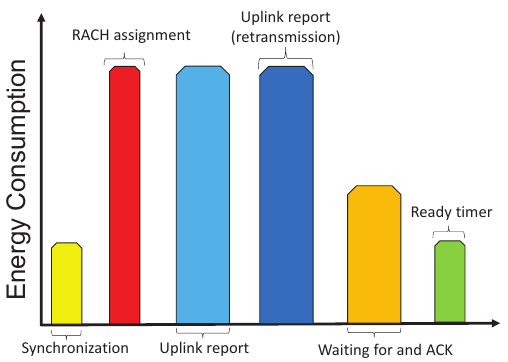
Figure 3. Protocol flow for the uplink of NB-IoT showing an example of possible energy consumption.